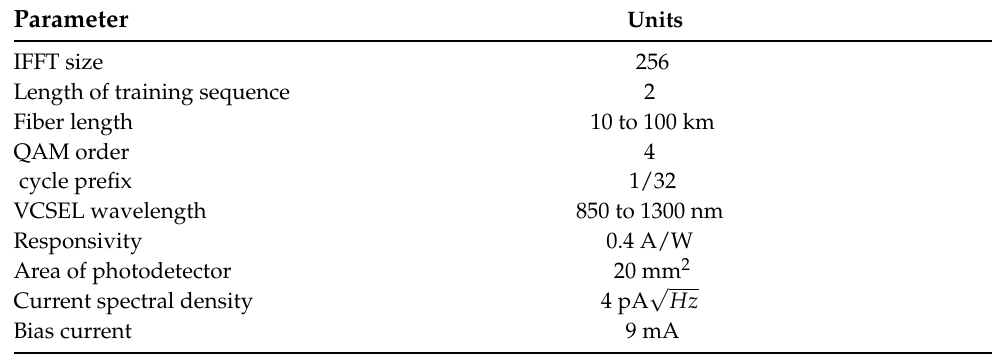
Table 1. ML-based VCSEL and OWN parameter list for investigating system